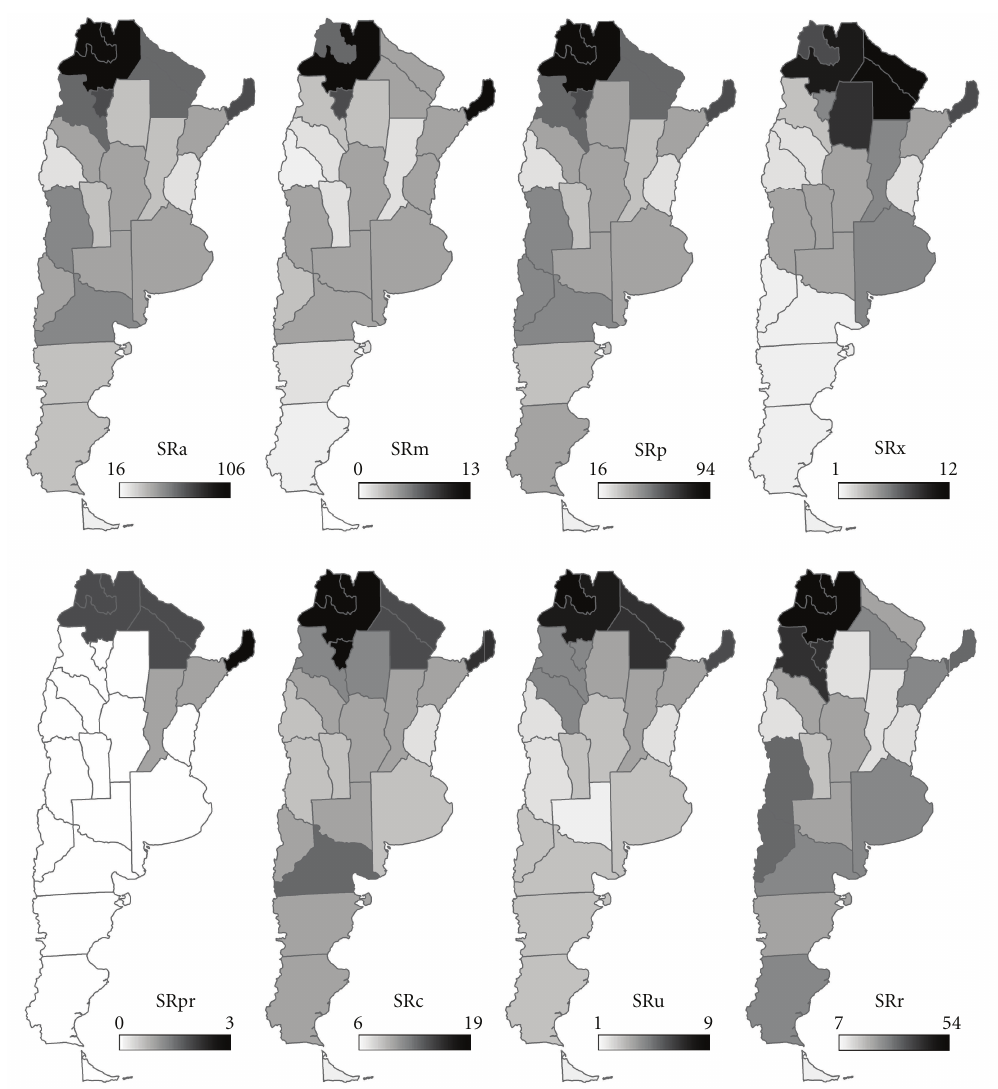
Figure 2: Species richness of indigenous nonvolant terrestrial mammals in each Argentinean province. SRa: all mammals; SRm: Marsupialia; SRp: Placentaria; SRx: Xenarthra; SRpr: Primates; SRc: Carnivora; SRu: Ungulates; SRr: